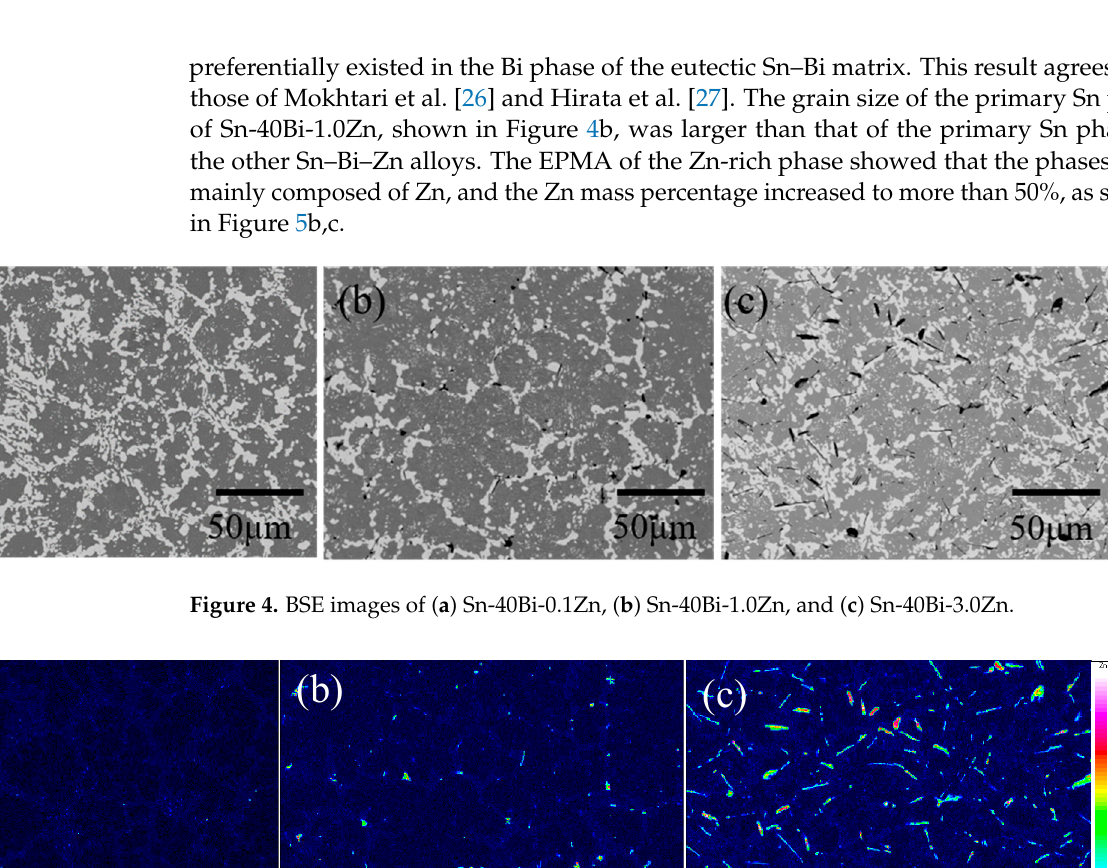
Table 1. EPMA results of the Sn-40Bi-Sb alloys.